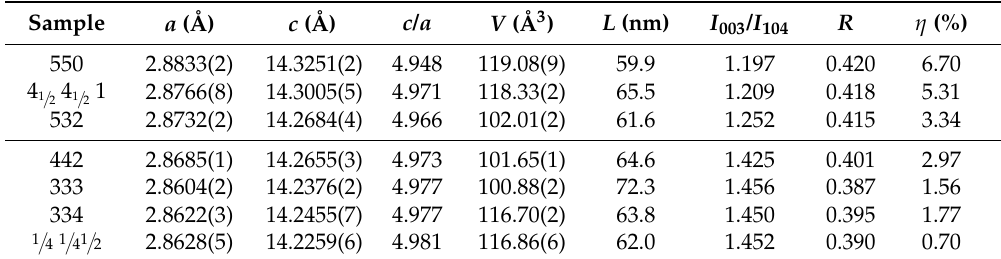
Table 1. Lattice parameters a , c , c / a of NMC materials, synthesized by solid-state reaction. V is the volume of the unit cell. L is the mean lattice coherence length. The last column is the ratio of the intensities of the XRD lines labelled by their Miller indexes and R = ( I 006 + I 102 )/ I 101 . The parameter η reveals the site-exchange rate of Ni 2+ (3 b ) cation mixing.